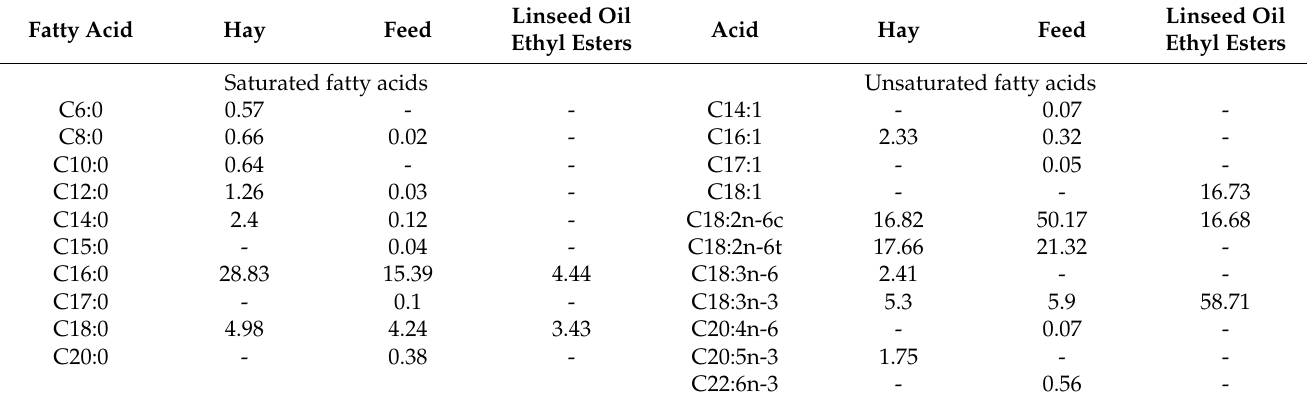
Table 2. Average fatty acid content of basic feed, hay and ethyl esters of PUFAs obtained from linseed oil [8].